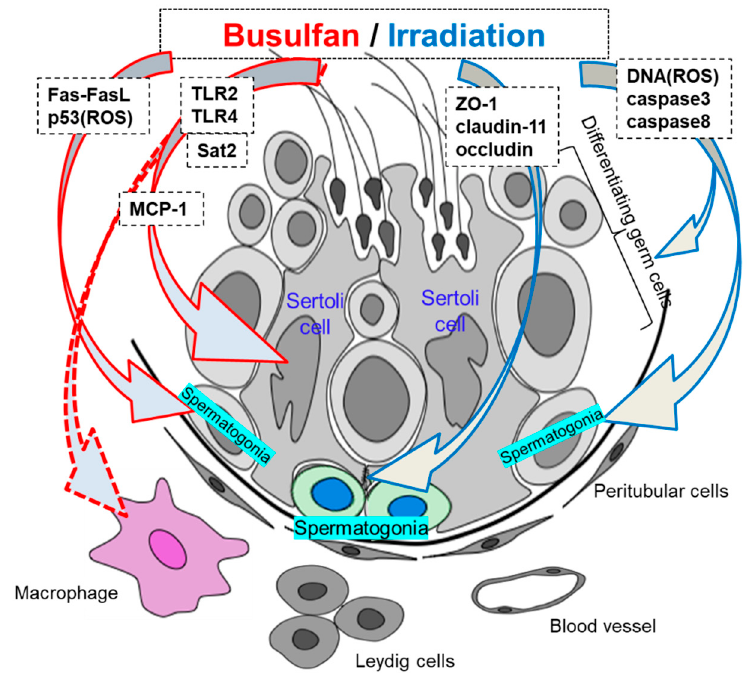
Figure 1. Immunological differences in the testes after cancer treatment.